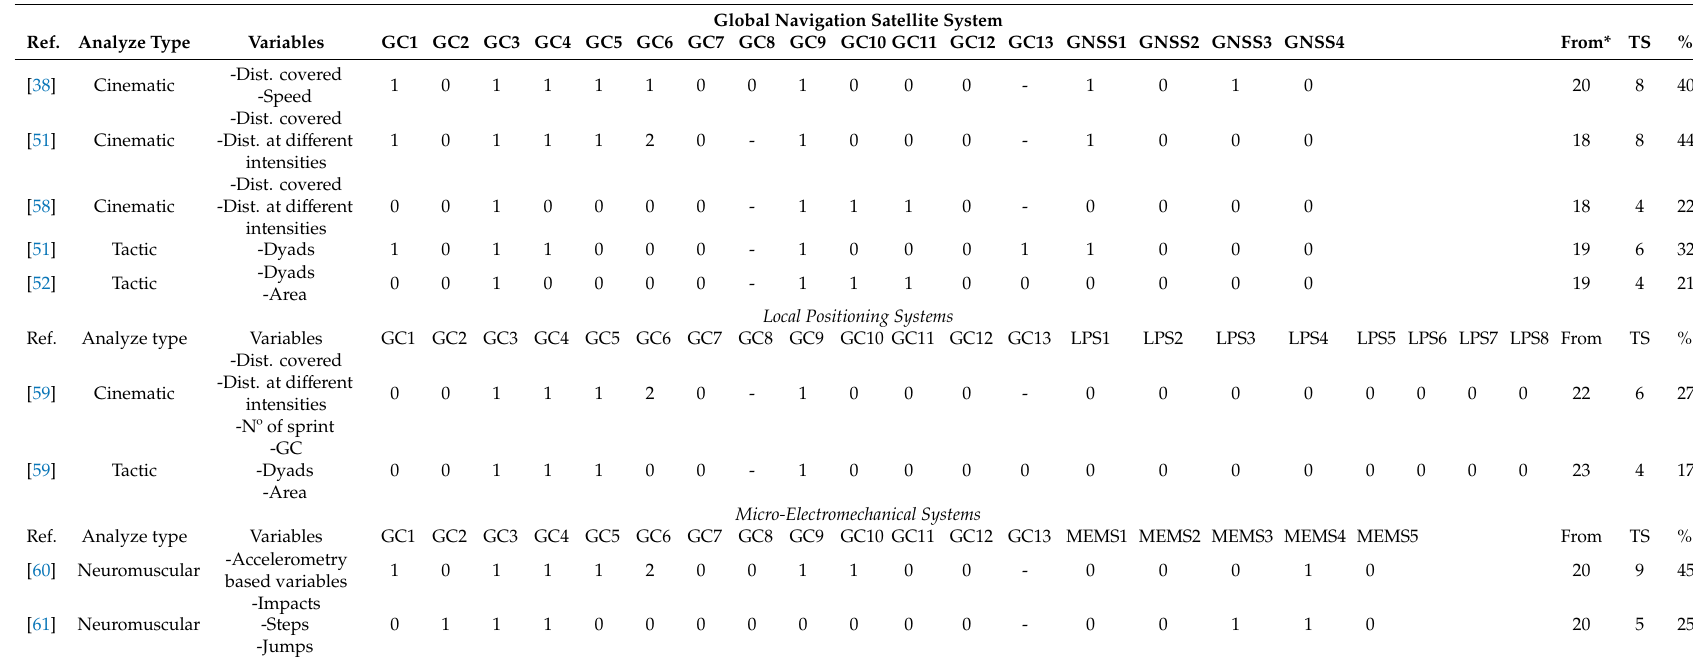
Table 5. Practical application of the survey in the di ff erent types of analyses with di ff erent technologies. Global Navigation Satellite System Ref. Analyze